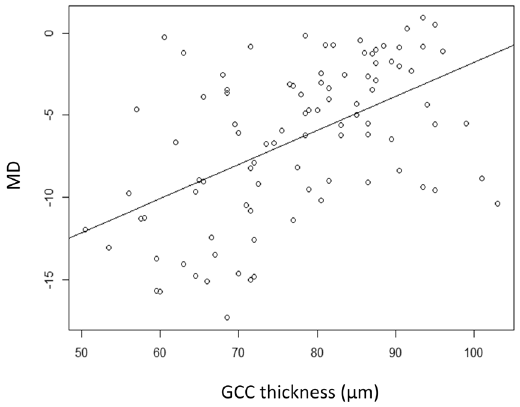
Figure 4. Relationship between the mean deviation (MD) and the ganglion cell complex (GCC) thickness. A significant relationship was observed between the MD and GCC thickness [MD = − 22.5 + 0.21 (standard error,